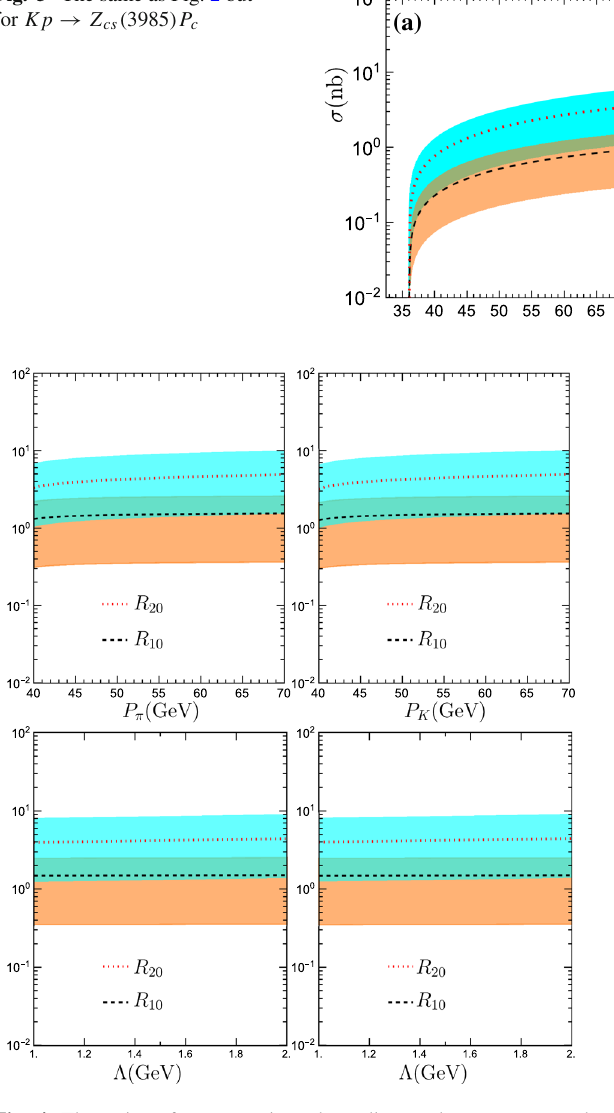
Fig. 4 The ratios of cross sections depending on beam energy and model parameter (cid:5) . Diagram a and b present the beam energy depen- dencesforprocesses π p → Z c ( 3900 ) P c and Kp → Z cs ( 3985 ) P c with (cid:5) = 2 . 0, respectively. Diagram c and d present the model parameter dependences for π p and Kp reactions with beam energy to be 55 GeV, respectively. The bands are the uncertainties resulted from the error of P c / P cs widths P c ( 4312 ) , P c ( 4440 ) , and P c ( 4457 ) are very similar, then one can define cross sections ratio as